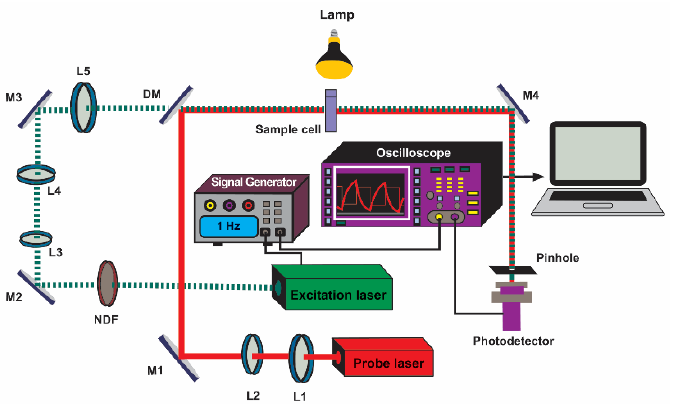
Figure 2. Scheme of the TLS experimental setup. L1, L2, L3, L4, L5: lenses; M1, M2, M3, M4: turning mirrors; DM: dichroic mirror; NDF: neutral density filter.